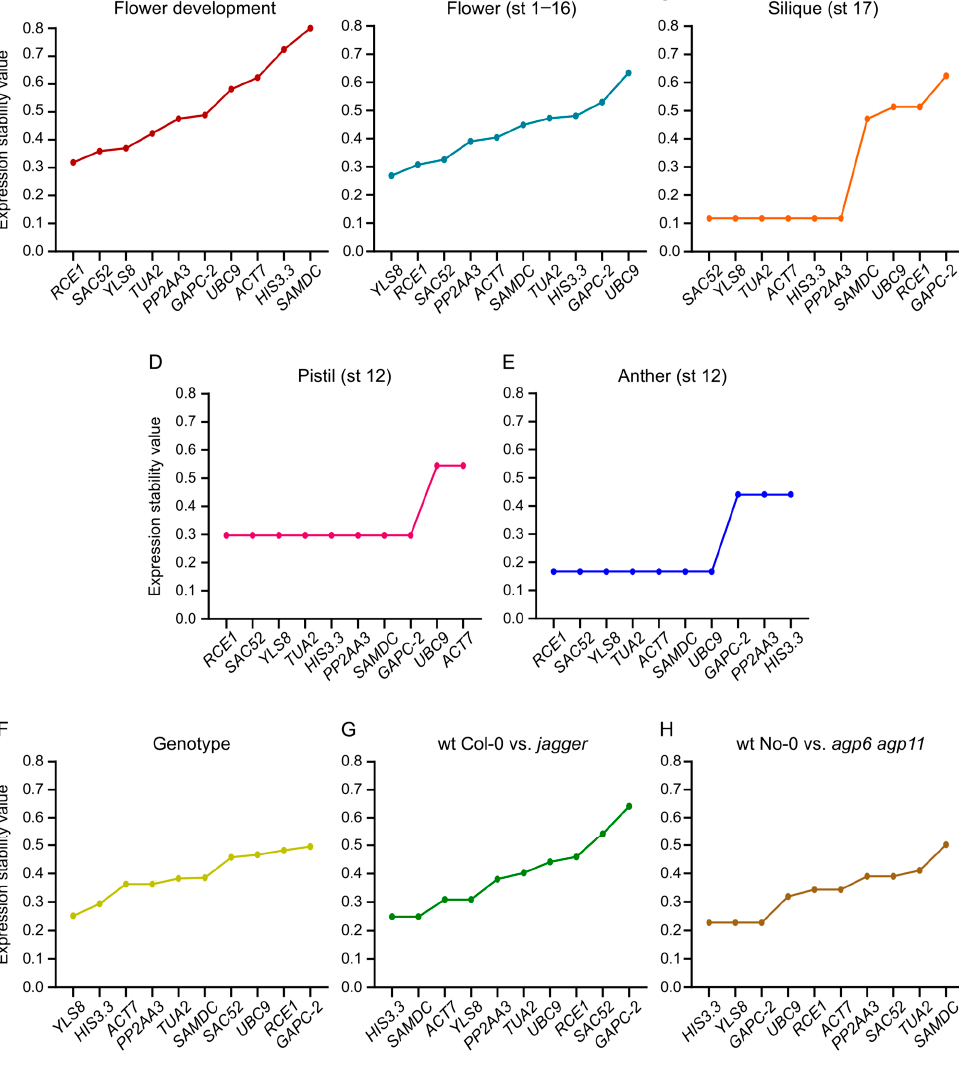
Figure 4. Expression stability values of the ten candidate reference genes calculated by NormFinder in the RefFinder software. ( A ) Expression stability values of the ten candidate reference genes in the flower development group which included 21 samples corresponding to flower (st 1–16), silique (st 17), pistil (st 12), and anther (st 12) samples. ( B ) Expression stability values of the ten candidate reference genes in 12 flower (st 1–16) samples which included flower st 1–6, flower st 7–12, flower st 13–14, and flower st 15–16 samples. ( C ) Expression stability values of the ten candidate reference genes in the three silique (st 17) samples. ( D ) Expression stability values of the ten candidate